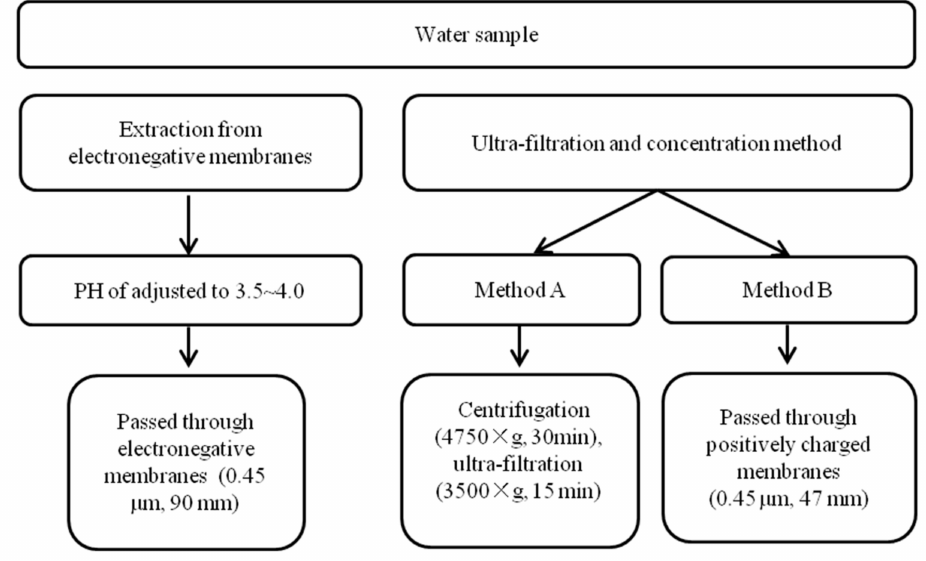
Figure 4. Summary of pre-treatment methods for nucleic acid determination of water samples